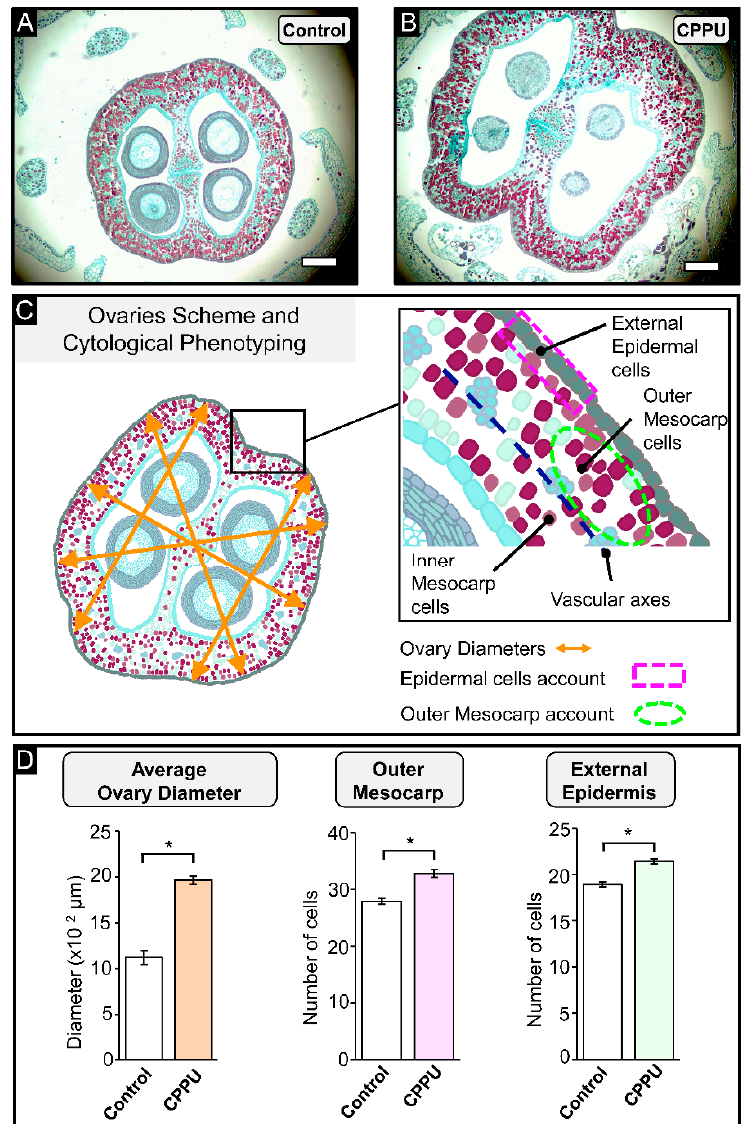
Figure 2. Pre-anthesis CPPU treatment modifies the ovary morphology at the anthesis stage: cross-section of cv. Thompson Seedless untreated ( A ) with two CPPU applications ( B ). Schematic representation of measurements on grape ovary images using Fiji software ( C ): the average ovary diameter was